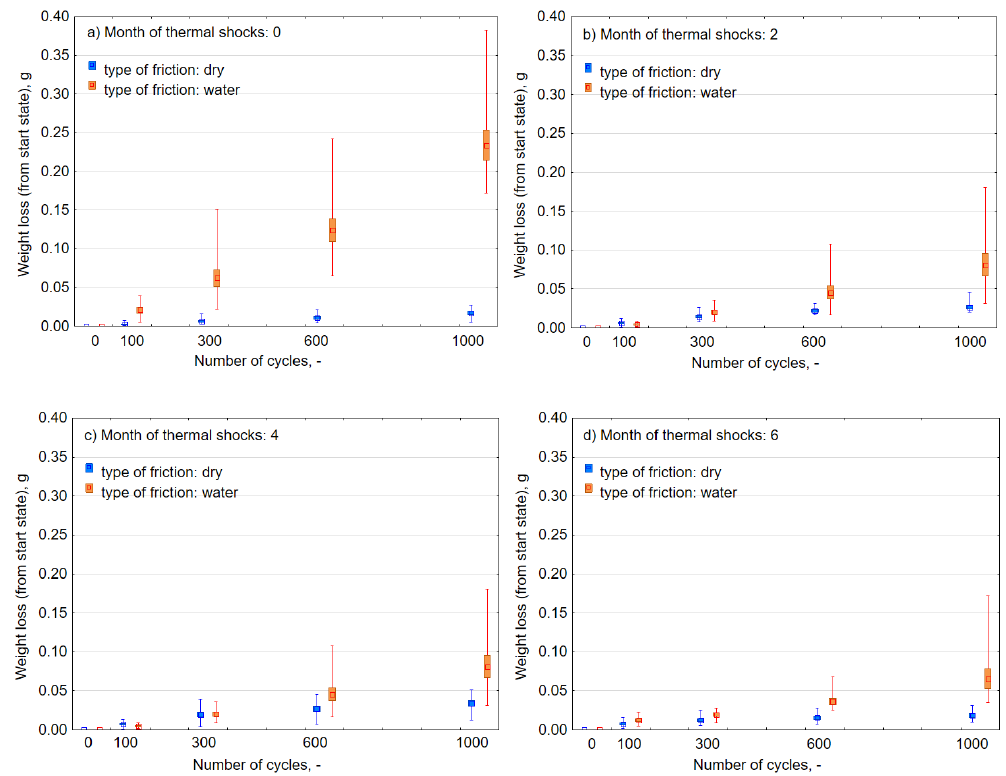
Figure 15. Average weight loss of individual samples subjected to thermal shocks, after the assumed number of cycles of dry and wet abrasion, ( a ) 0, ( b ) 2, ( c ) 4, and ( d ) 6 months of thermal schocks.